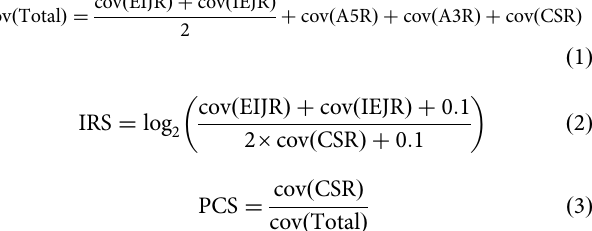
Fig. 1 Phenotypes of cells lacking the m 6 A modi fi cation in U6 snRNA. a Primary and secondary structures of U6 snRNA from S. pombe with the following post-transcriptional modi fi cations: CH 3 OpppG ( γ -methyl triphosphate cap), N 6 -methyladenosine (m 6 A), 2 ′ O -methylations (Nm), and 2 ′ ,3 ′ cyclic phosphate (>p). 5 ′ SL and ISL represent the 5 ′ stem loop and internal stem loop, respectively. The underlined sequence represents the ACAGA box. b Loss of m 6 A in U6 snRNA isolated from SPAC27D7.08c knockout ( mtl16 Δ ) cells. Mass chromatograms of the RNase A-digested fragments of U6 snRNA containing m 6 A37 or A37 isolated from S. pombe WT and mtl16 Δ cells. n.d., not detected. c In vitro reconstitution of m 6 A in U6 snRNA catalyzed by S. pombe Mtl16 in the presence or absence of SAM. Mass chromatograms of the RNase A-digested fragments of U6 snRNA containing m 6 A37 or A37. d Growth phenotypes of S. pombe WT and mtl16 Δ strains cultured at 30 °C or 37 °C on YE5S plates supplemented with the indicated inducers of cell stress. The plates were photographed 3 – 4 days after inoculation. TBZ, thiabendazole; HU, hydroxyurea. e Doubling times of WT and mtl16 Δ cells were measured in glucose (YE5S) and glycerol media. OD 600 was measured every hour for 12 h. The asterisk indicates a statistically signi fi cant difference in the doubling time of the two strains, as determined by two-sided Student ’ s t -test. * p = 7.7e-5; n = 3 biologically independent samples. Data are presented as mean values + / − SD. Source data are provided as a Source Data fi le. f Northern blotting of S. pombe U snRNAs in total RNA of WT and mtl16 Δ cells. 5 S rRNA